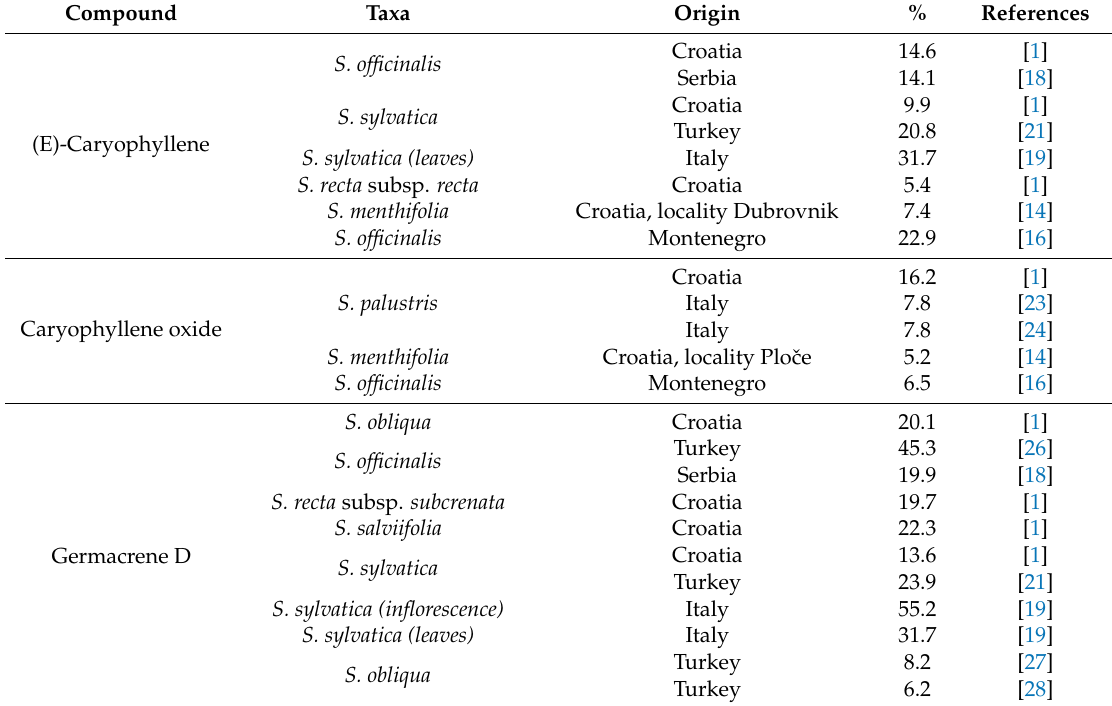
Table 2. Main sesquiterpenes and monoterpenes recorded in Stachys taxa (percentige above 5%